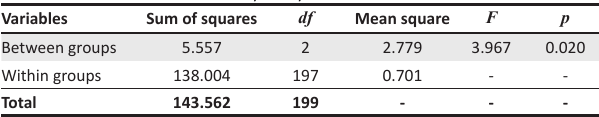
TABLE 10: Results for the one-way analysis of variance test.